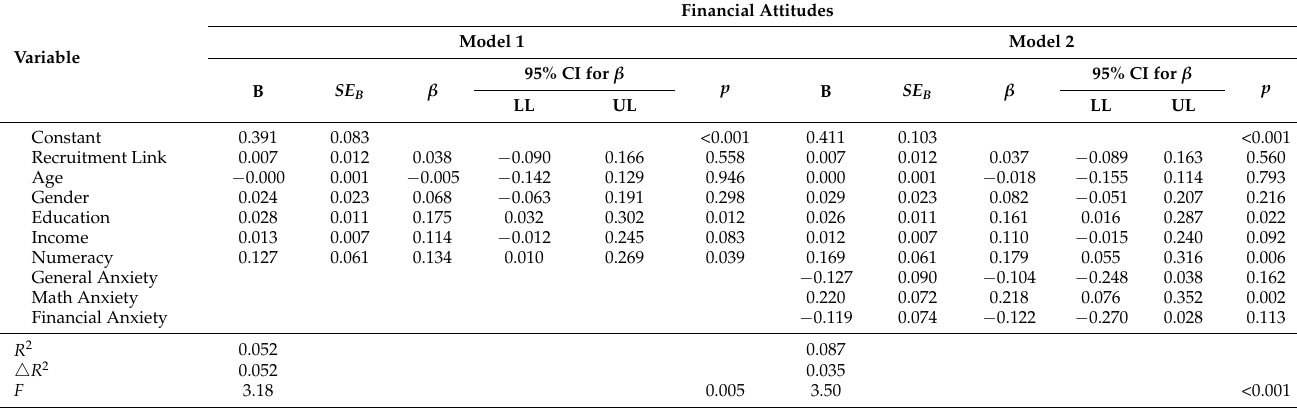
Table 4. Multiple Regression Assessing Factors Related to Financial Attitudes.